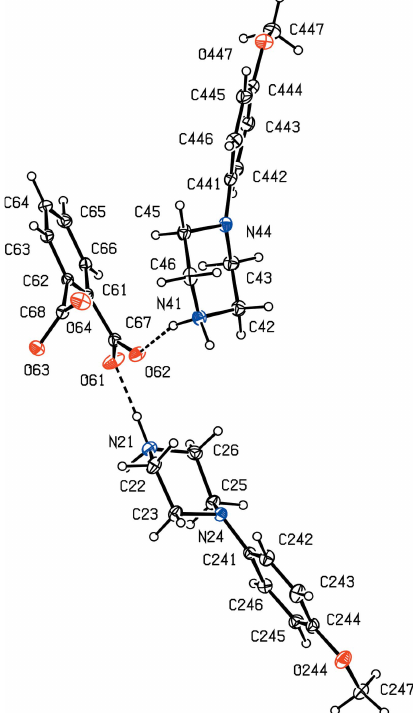
Figure 3 The independent components in the type 2 ion triplet in compound (II), showing the atom-labelling scheme and the hydrogen bonds, drawn as dashed lines, within the selected triplet. Displacement ellipsoids are drawn at the 30% probability